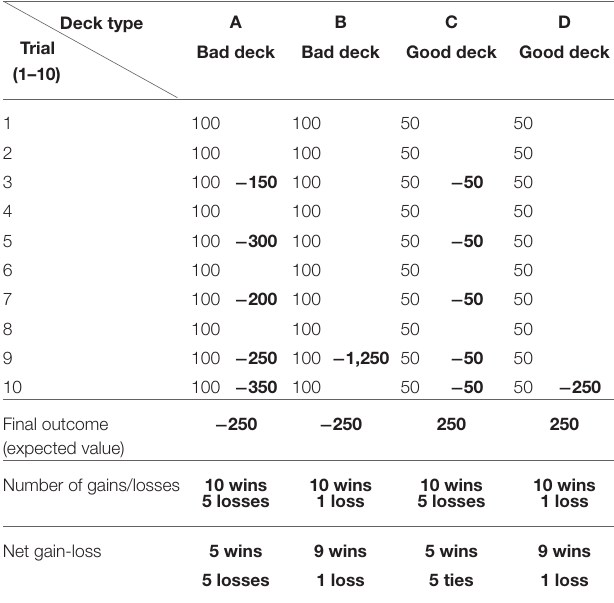
TABLE 1 | IGT gain–loss structure.